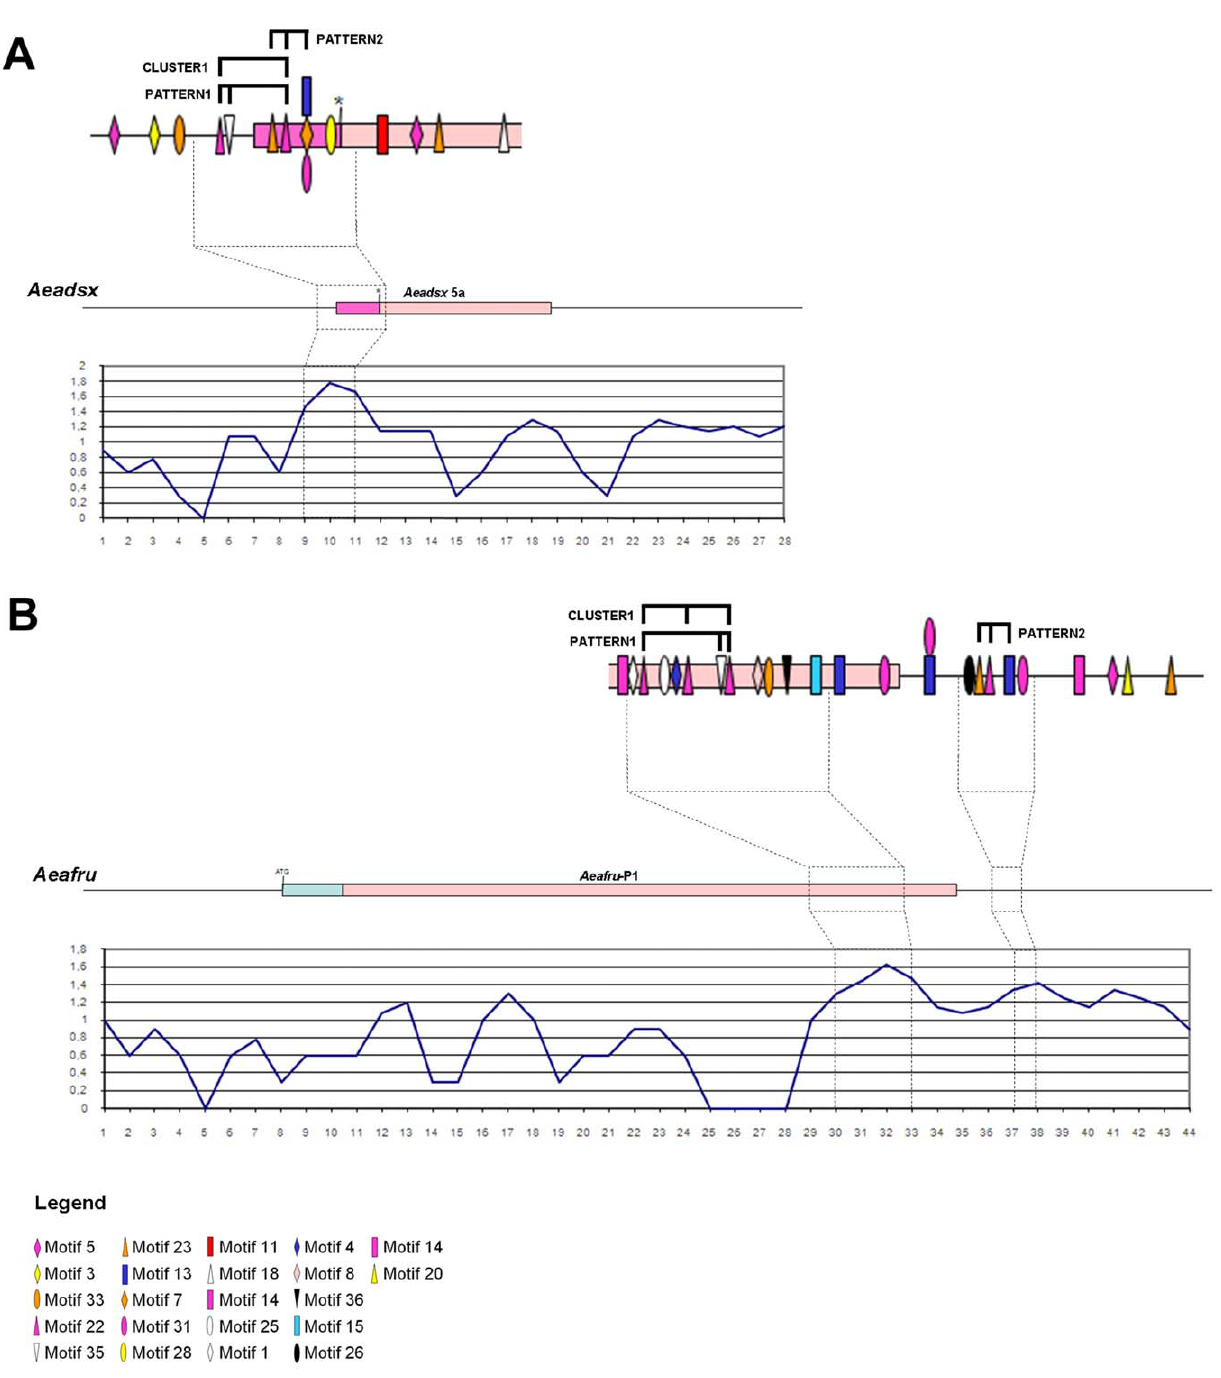
Figure 6. Sliding window analysis of MEME identified motifs. Schematic diagram of the sliding window analysis performed on (A) Aeadsx and (B) Aeafru sex-specifically regulated regions. Both regions are represented in scale and aligned with the corresponding sliding window graph. Each sliding window is 100 bp long and overlaps for 50 bp with the following and preceding sliding windows; each x axis position represent the nucleotide position of the centre of the sequence window. Scores (y axis) are calculated as described in Methods Section and are expressed in log 10 of the total sliding window score multiplied for 2. Motif legend is reporter below graphs. doi:10.1371/journal.pone.0048554.g006 blue rectangle). Out of 38 motifs, the 8 nt long motif 22 (indicated